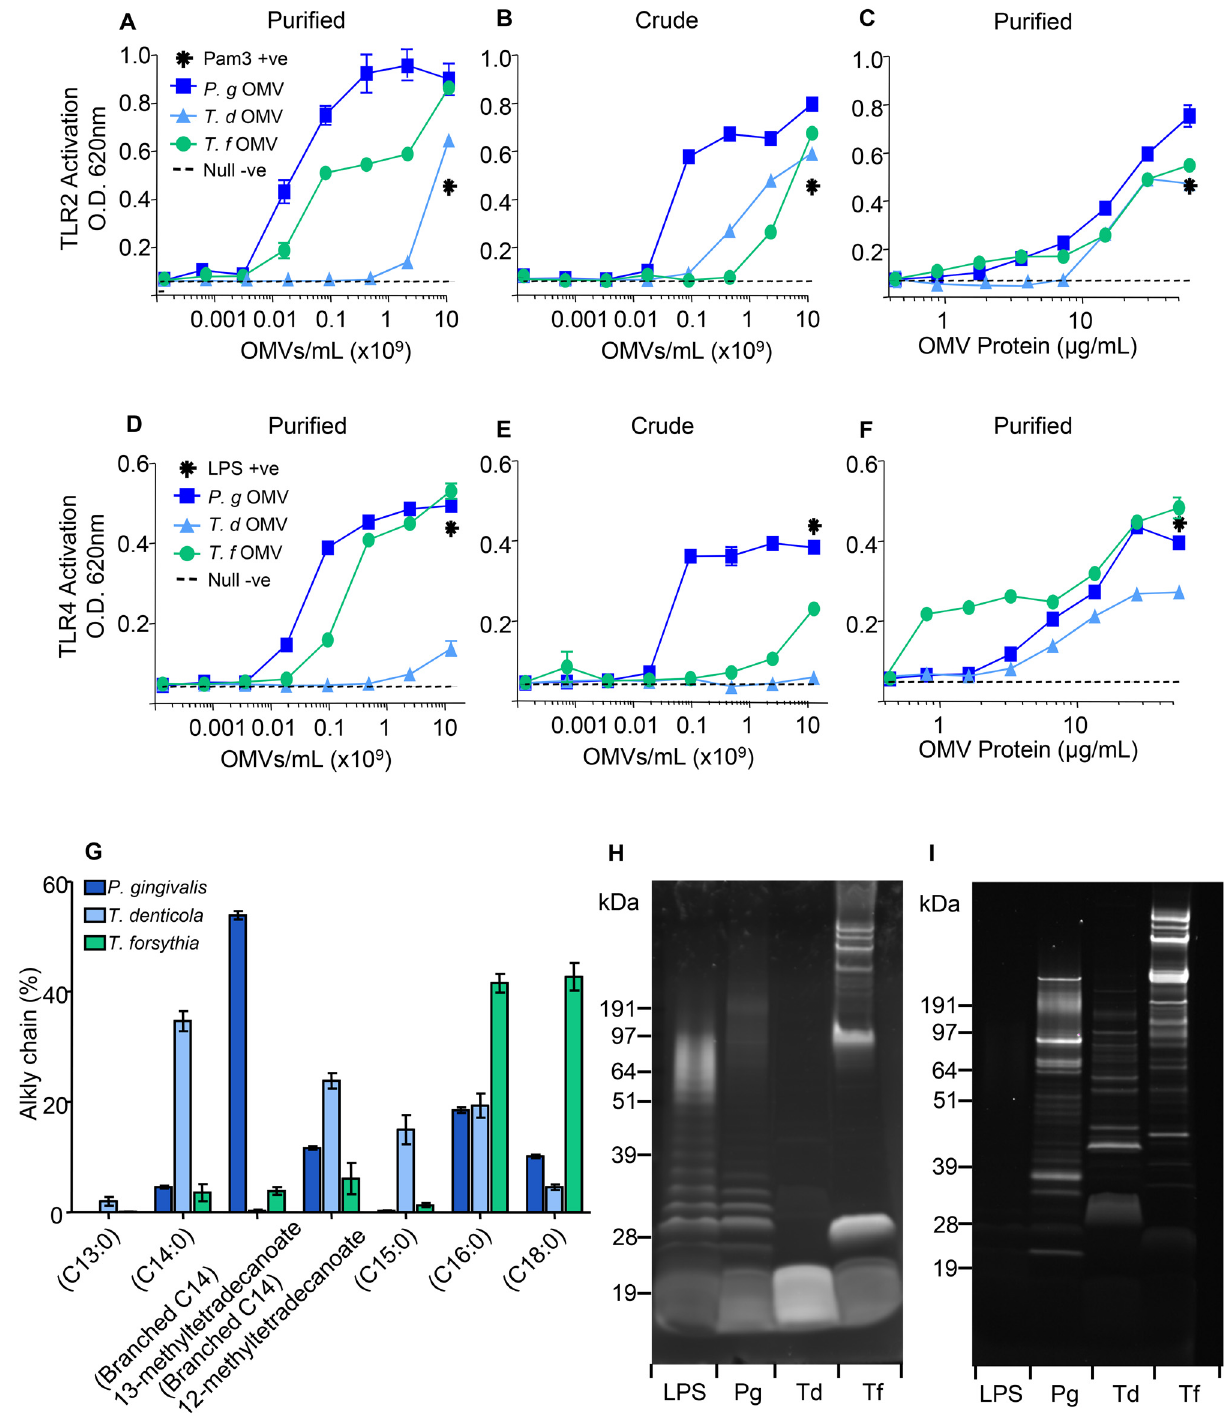
Fig 3. TLR2 and TLR4 Activation by P . gingivalis , T . denticola and T . forsythia OMVs. HEK-Blue TLR2 (A, B, C) and TLR4 (D, E, F) Cell lines were incubated with 20 μ L of either OMVs or ligands Pam3CSK4 (10 μ g/mL in 5 fold dilutions) and LPS-EB (10 μ g/mL in 10 fold dilutions) respectively.